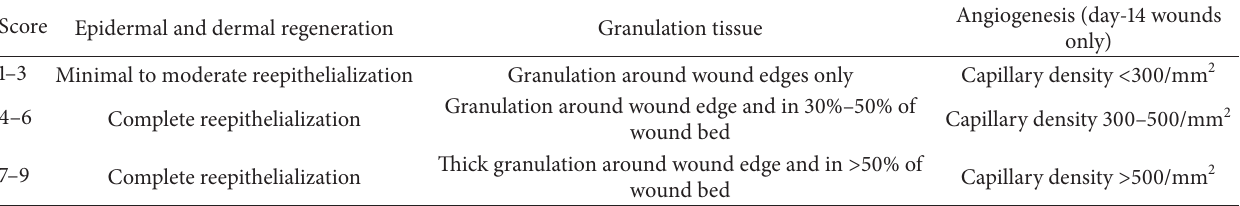
Table 1: Criteria for wound scoring.